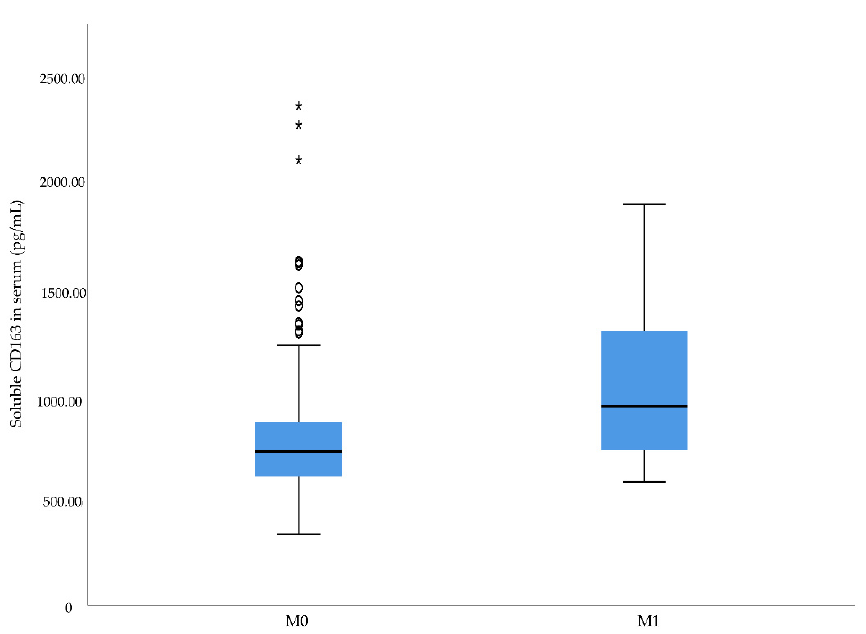
Figure 3. Soluble hemoglobin scavenger receptor (CD163) serum levels in renal cell carcinoma patients with or without metastatic disease at time of diagnosis, p = 0.041. Outliers in the data are represented by a circle (°), and extreme outliers are represented by an asterisk (*).